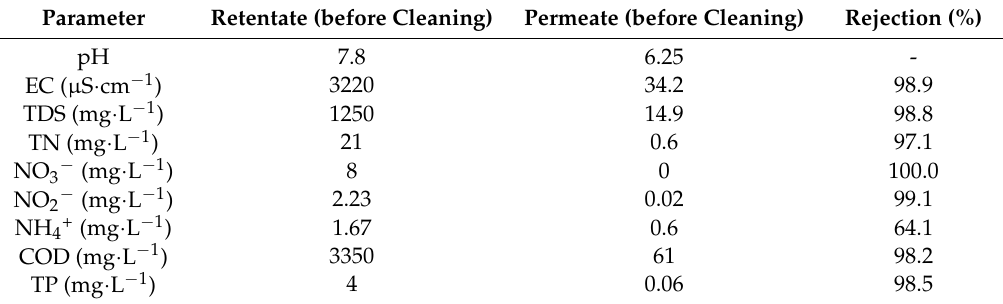
Table 2. Retentate and permeate quality of the standard hydrophobic membrane.